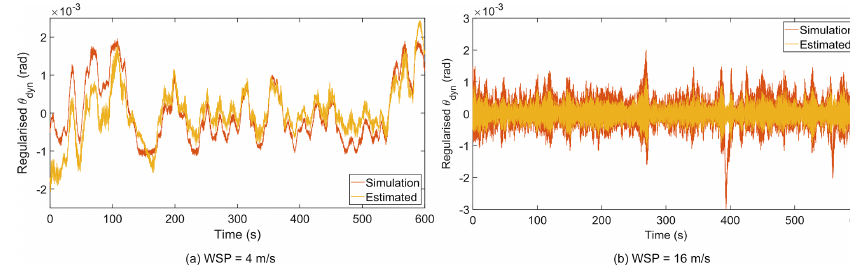
Figure 6. Comparison of regularised θ dyn with the results from aeroelastic simulation. WSP: mean wind